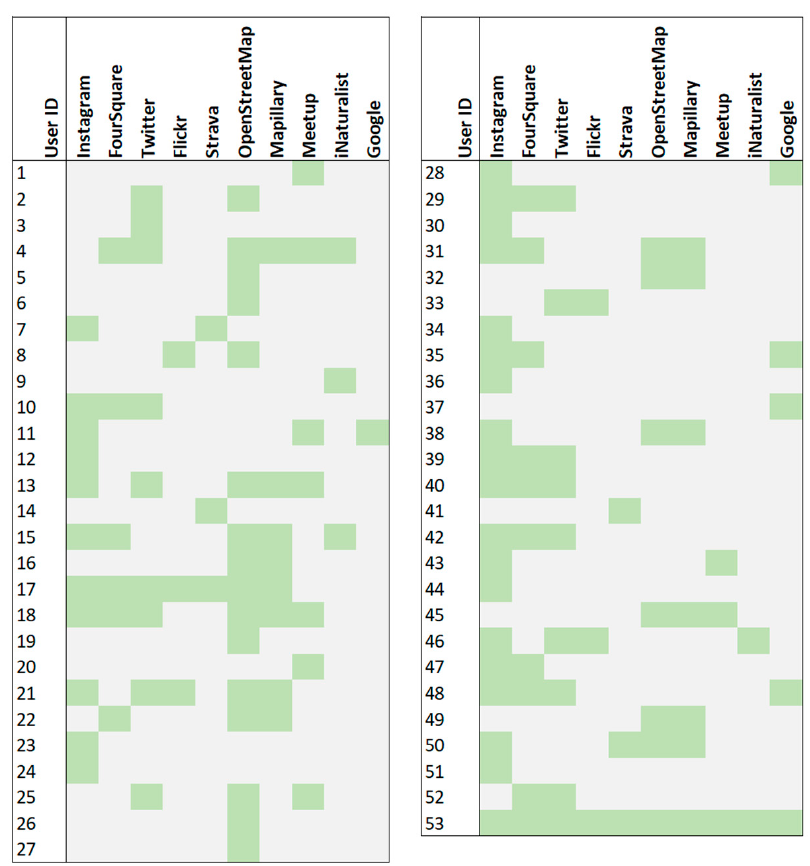
Figure 2. Social media and crowdsourcing platforms used by a set of 53 users.